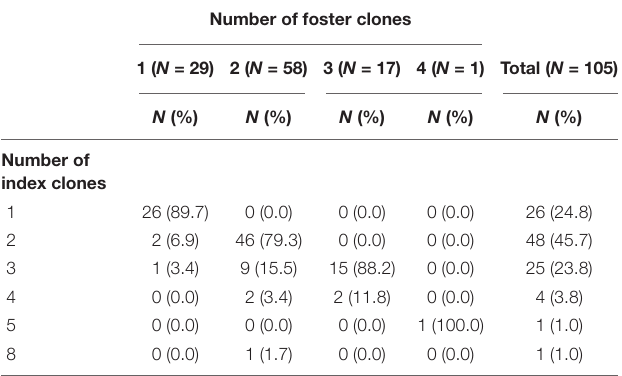
TABLE 2 | Distribution of the number of index clones and foster clones. Number of foster clones